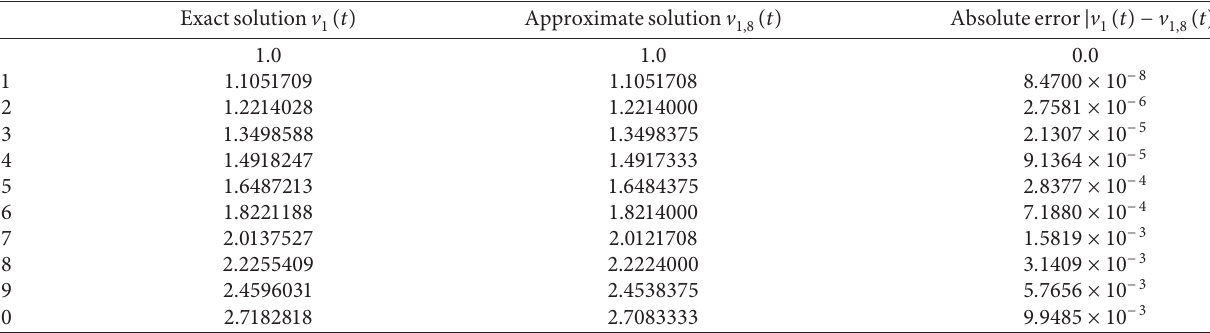
( t ) and approximate v ( t ) solutions for Example 1 at β � 1 and k � 8 over the interval [0, 1]. 1 1 , 8